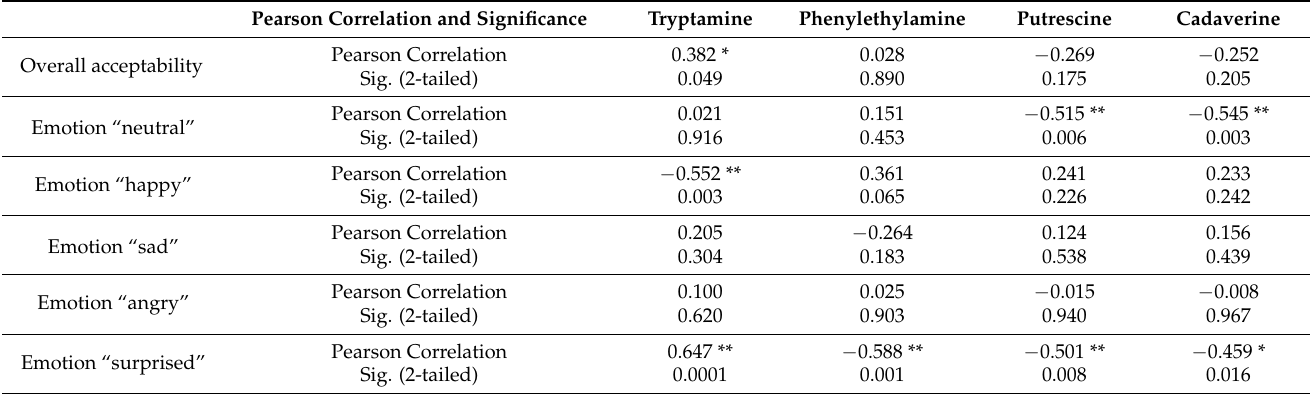
Table 7. Correlation between biogenic amines concentration in beer samples and beer overall acceptability and emotions induced for